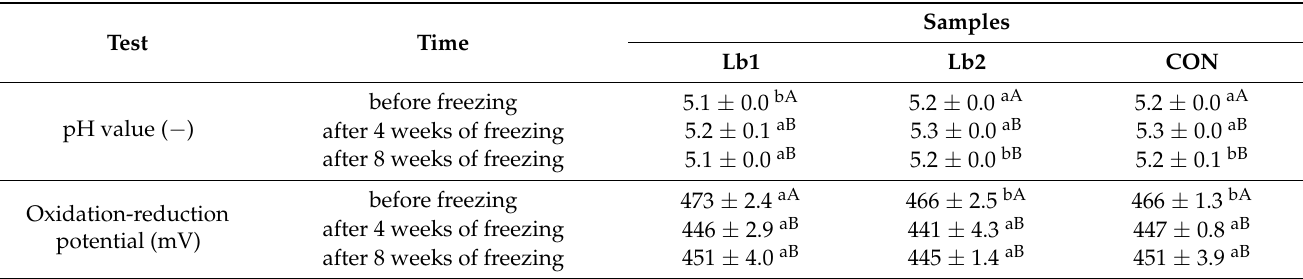
Table 3. Physicochemical analysis of the non-dairy ice cream dessert during freezing.